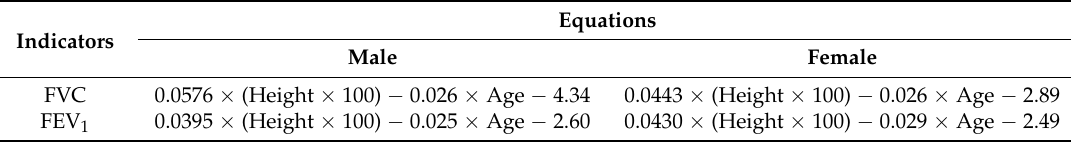
Table A1. Equation of calculating individual predicted value of lung function indicators developed by European Respiratory Society (ERS) in 1993.